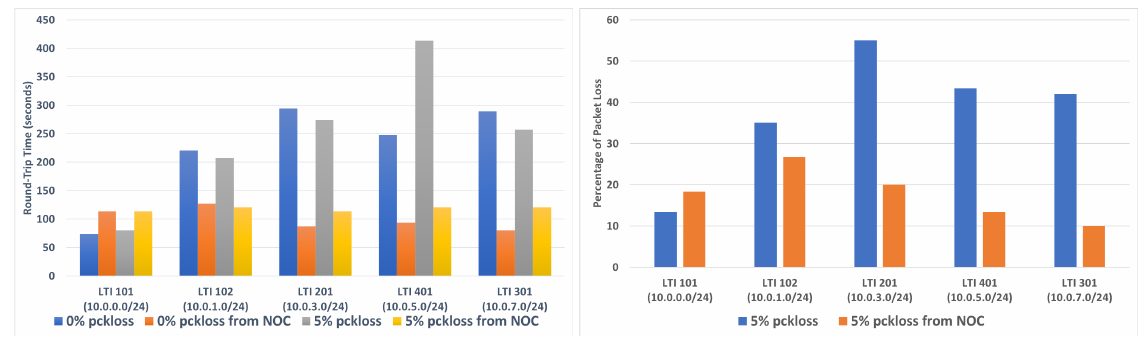
Figure 12. Unit Assignment - Assigning a Lower-Tier Network to the Networks